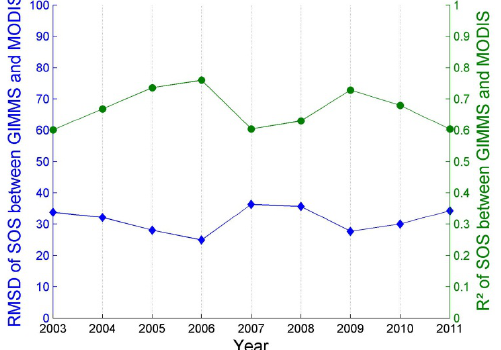
Figure 14. ( top ) annual analysis of the pixel-wise correlation between SOS from GIMMS and MODIS with coefficient of determination (R 2 ) and root mean square difference (RMSD). ( bottom ) inter-annual distribution of SOS for GIMMS ( left ) and MODIS ( right ). The box-and-whisker plots show the median in red. Box edges represent the 25th and 75th percentiles. The whiskers extend to data points still within the 1.5 interquartile